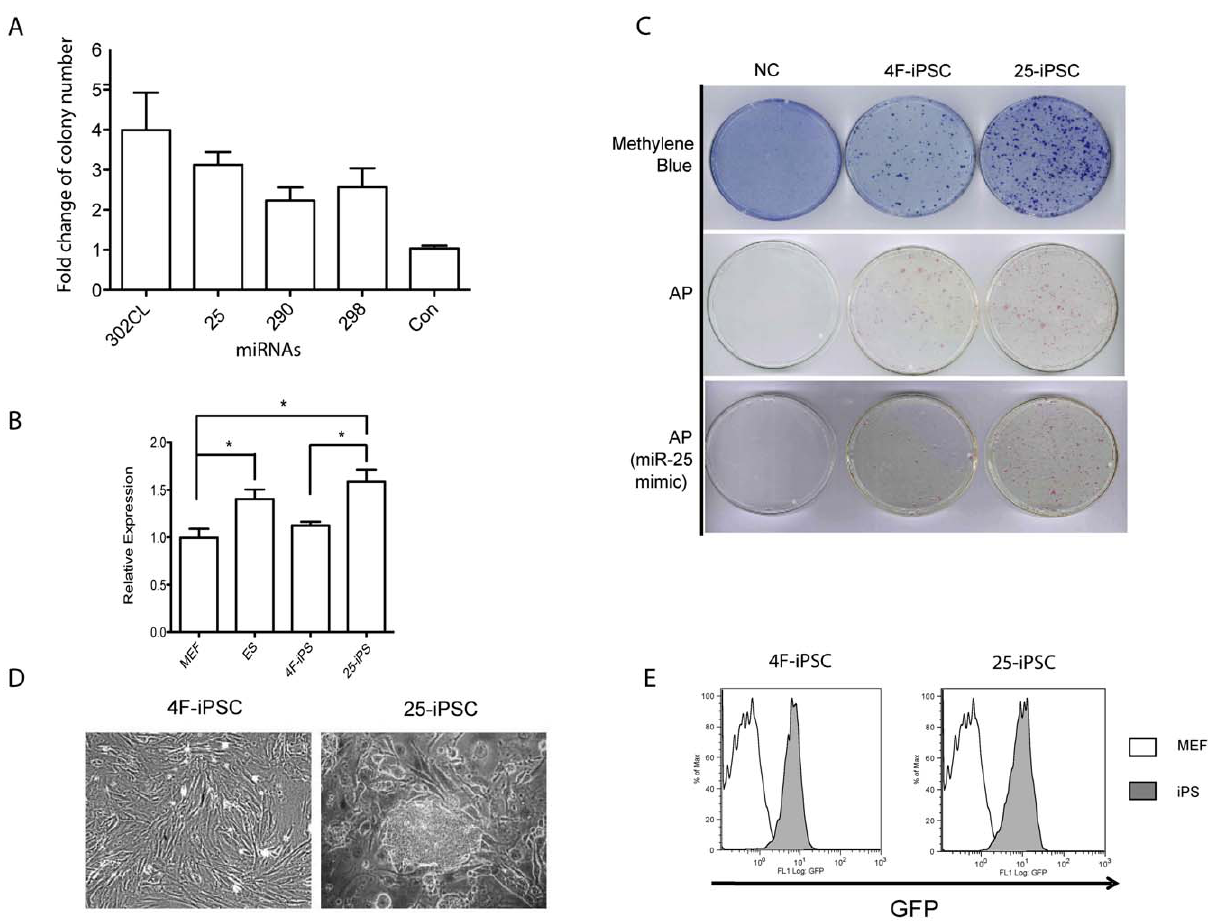
Figure 2. Co-expressing OCKS and microRNAs improved reprogramming. a. Four microRNAs: miR302 (cluster), miR-25/93, miR-290 and miR-298 were able to improve reprogramming. Shown here is the fold change of iPSC colony number (2.0 m g/ml Puro r ). Fold changed was calculated based on the iPSC colony number using the four factors only (mean 6 SEM. N=4). b. qPCR analysis of the mature form of miR-25 expression. Expression was determined by qPCR and normalized using Sno202 miRNA. Data are mean 6 SEM from three cell lines. * P , 0.05. c. Reprogrammed colonies (2.0 m g/ml Puro r ) stained either by Methylene blue or for Alkaline Phophatase activity (AP). NC: negative control using a PB-Neo plasmid with no reprogramming factors; 4F-iPSC: iPSCs reprogramming by expressing OCKS (Dox inducible); 25-iPSC: iPSCs reprogramming by expressing OCKS (Dox inducible) and miR-25. Mimic: Transfection used a miR-25 mimic instead of the PB-CAG-mir25. d. A primary iPSC colony reprogrammed with the four Yamanaka factors and miR-25. e. GFP expression from the Oct4 locus in 4F-iPSCs and 25-iPSCs detected by flow cytometry.